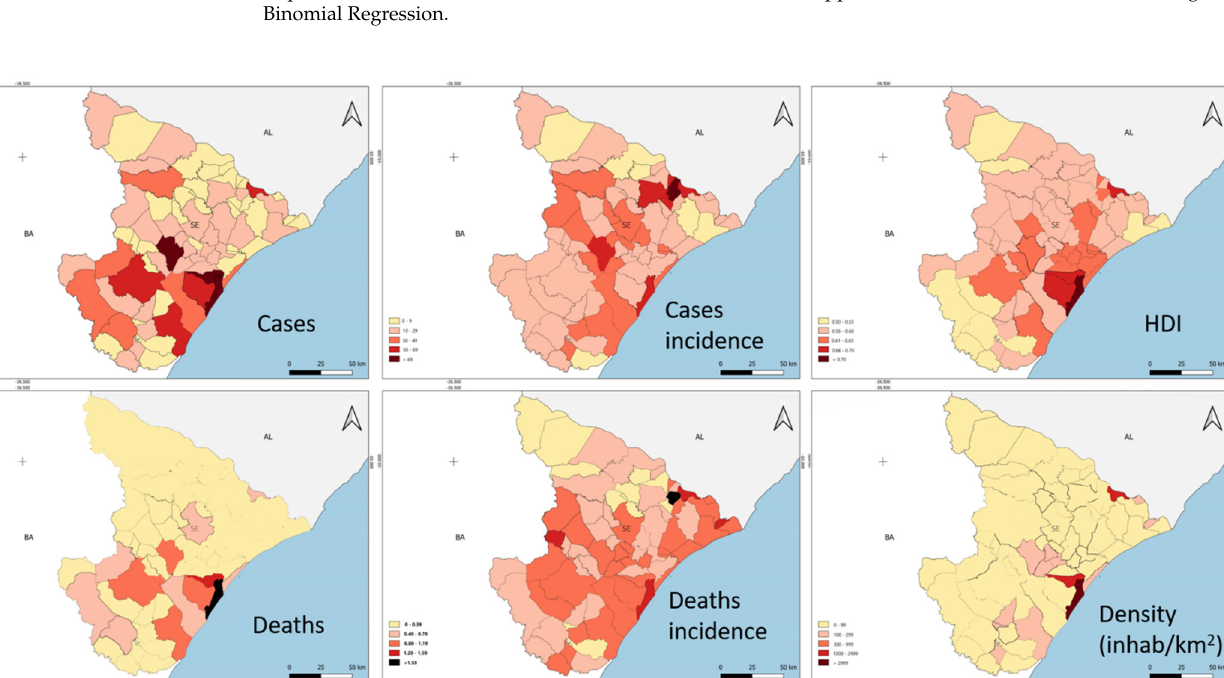
Table 3. Relation between incidence of COVID-19 cases and HDI of health regions in Sergipe—April